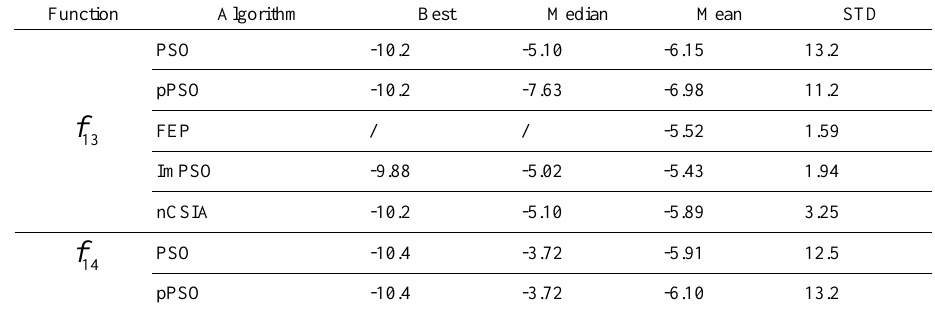
Table 4. Results comparison among PSO, pPSO, FEP, ImPSO, nCSIA for low dimensional multimodal functions. “/” means the item not